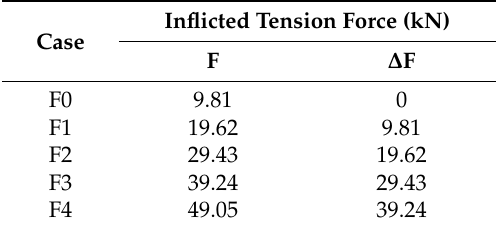
Table 4. Simulation cases of tension forces in axial cylindrical